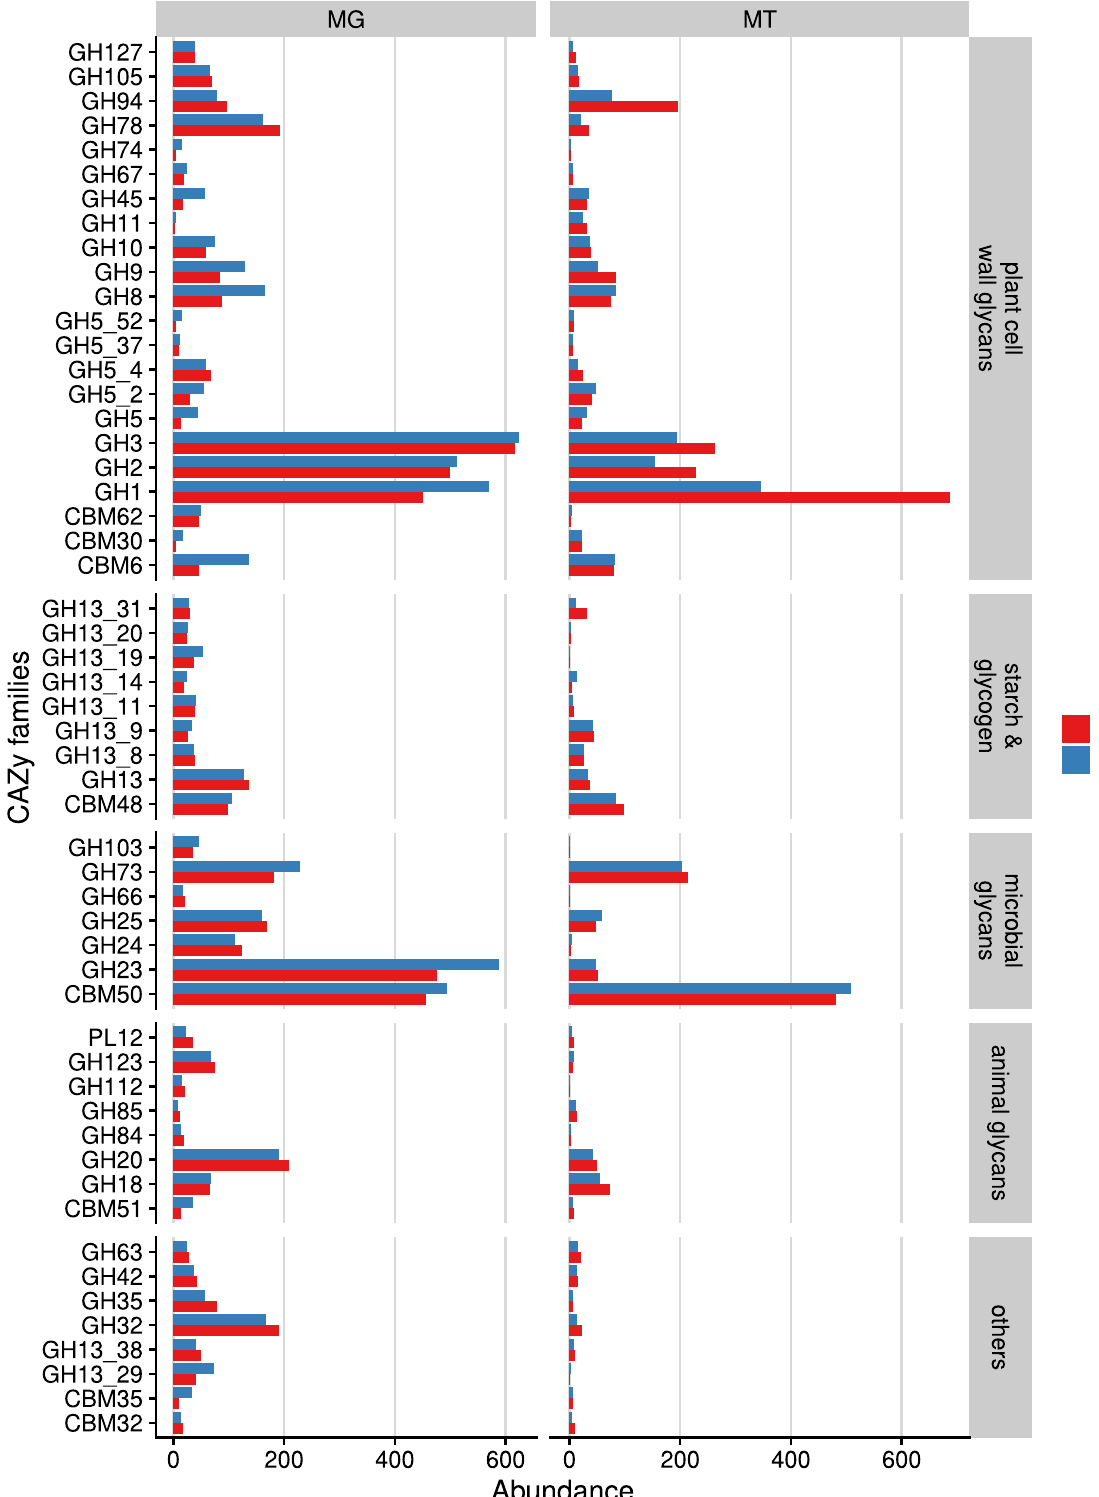
Fig. 3 Functional annotation of capybara metagenome co-assembly predicted genes according to carbohydrate-active enzymes database (CAZy). Cumulative abundance of main CAZy families predicted to act on distinct carbohydrates. Abundance is expressed as the cumulative TPM (Transcripts per Million). MG (metagenome) and MT (metatranscriptome) represent the average of three independent experiments ( n = 3), using fresh samples collected from the cecum and recto of three wild animals by abdominal surgical procedure. Source data are provided as a source data fi le.